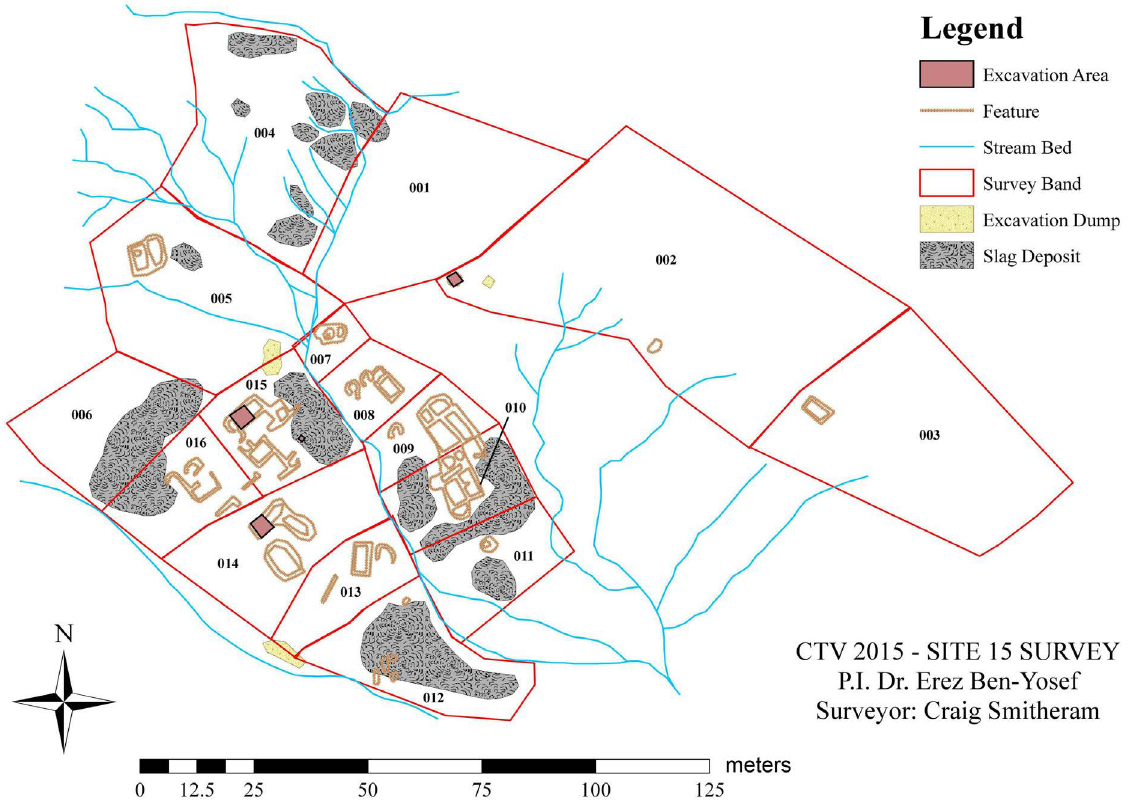
Figure 20. Site 15 survey map including bands and major architectural elements and slag mounds (from Ben- Yosef, in press